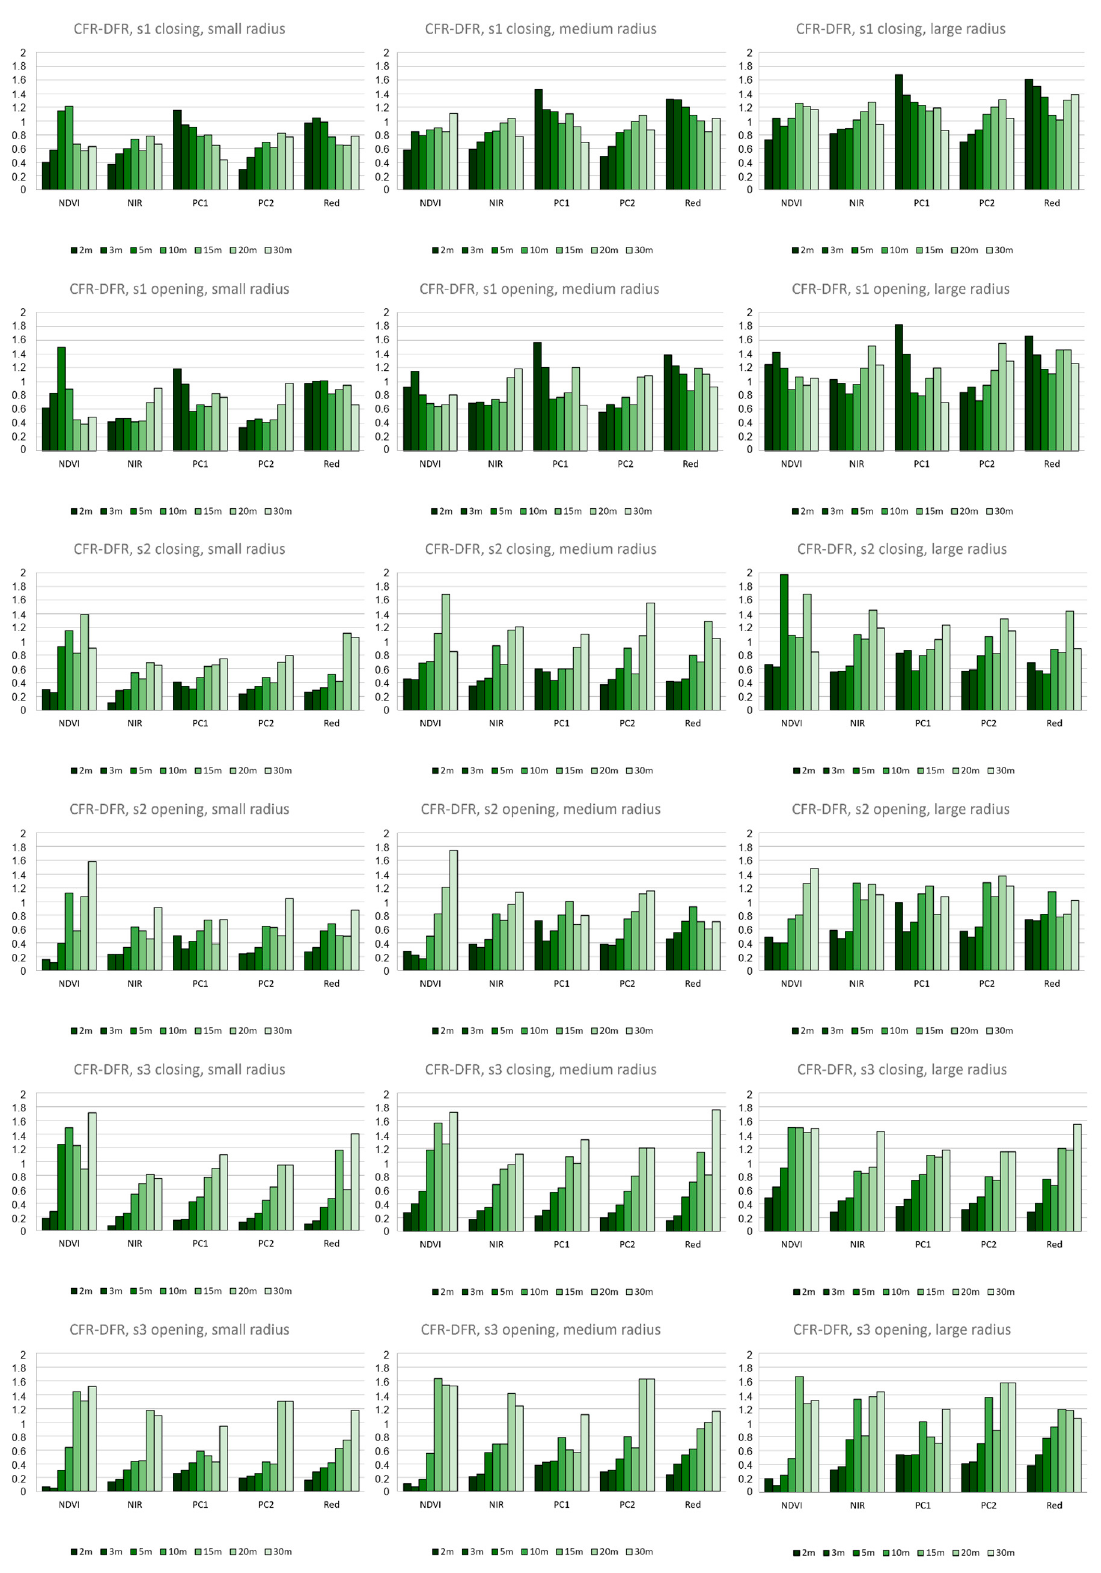
Figure 6. J–M distance diagrams for test fields for the coniferous forest/deciduous forest class pair (CFR/DFR).